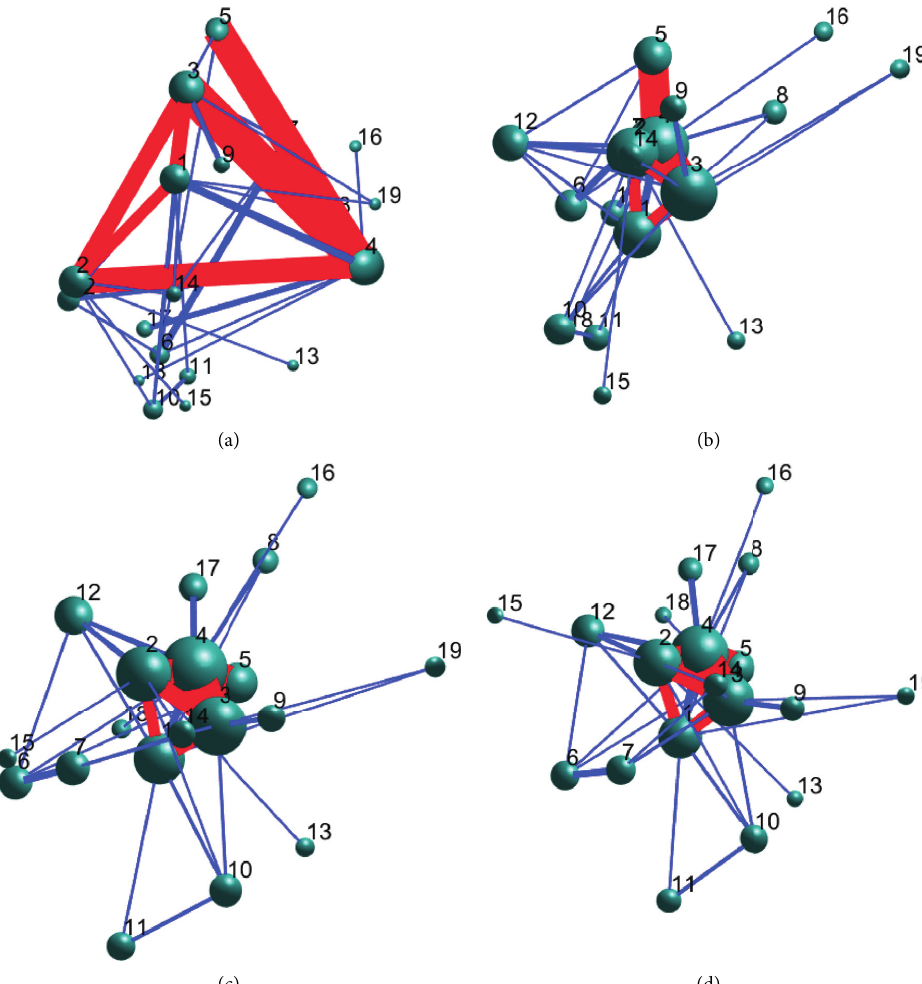
Figure 5: Snapshots of the process applying the proposed algorithm for “The Venice Merchant.” (a) Initial state of 19 nodes at n � 0. (b) Intermediate state of nodes at n � 10. (c) Intermediate state of nodes at n � 400. (d) Equilibrium state of nodes at n � 828.